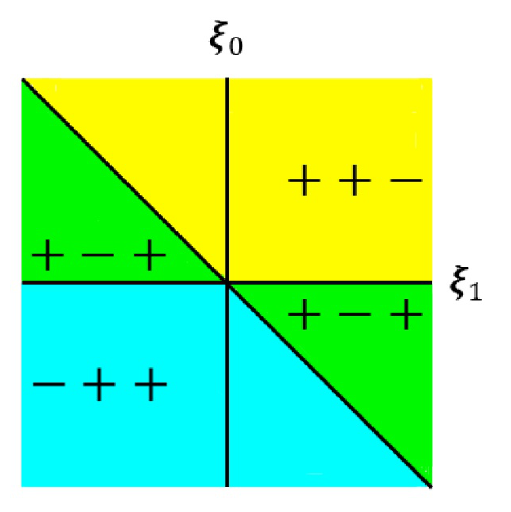
Figure 10 . This (cid:12)gure illustrates how the 6 regions of the FI space (separated by the solid black lines) are grouped into 3 distinct chambers, due to the symmetry under the exchange of the two NS5 + branes. Each chamber corresponds to a di(cid:11)erent ordering of the operators in the correlator